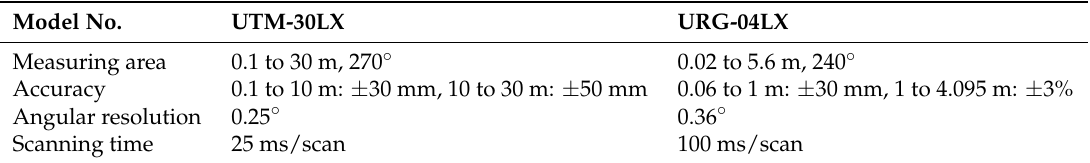
Figure 15. The robot is based on TurtleBot 2 with Kobuki base using either a Hokuyo UTM-30LX 2D LiDAR or a Hokuyo URG-04LX 2D LiDAR and an NVIDIA Jetson TX2. A wooden shell is placed on the top of the mobile platform to enable robots to detect each other. Table 4. The details of the Hokuyo 2D LiDAR